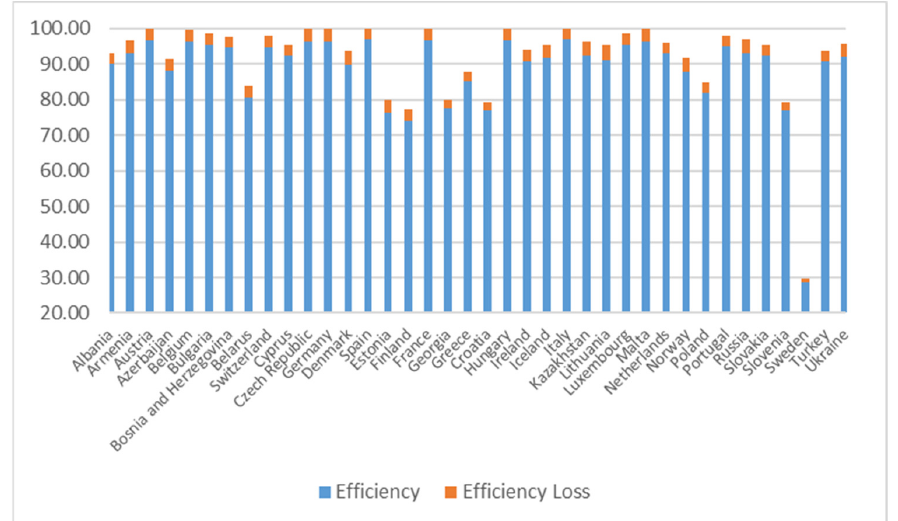
Figure 2. Average Efficiency and Average Efficiency Loss by country.